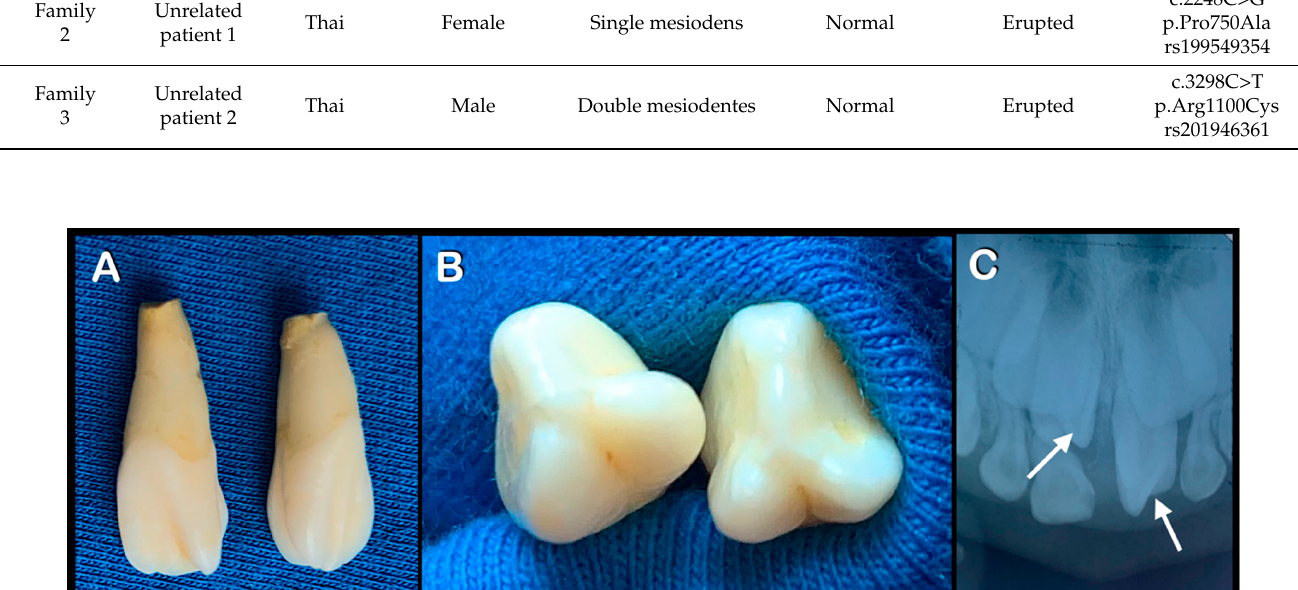
Figure 6. Unrelated patient 2. Extracted double mesiodentes in ( A ) Frontal view. ( B ) Top view. ( C ) Periapical radiograph prior to extraction (arrows). Note screwdriver-shaped crown morphology of both mesiodentes. Table 4. Clinical and molecular findings of patients and their family members (NM_015466.4; NP_056281.1).